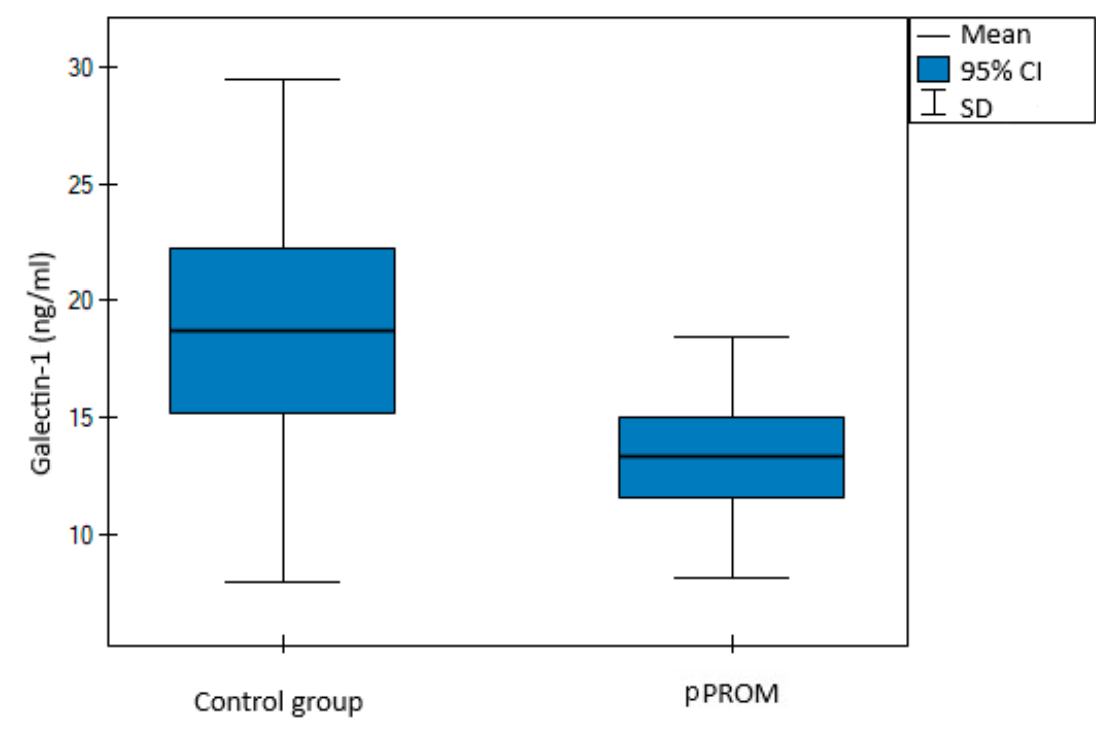
Figure 1. Distribution for maternal serum galectin-1 levels in study vs. control group.